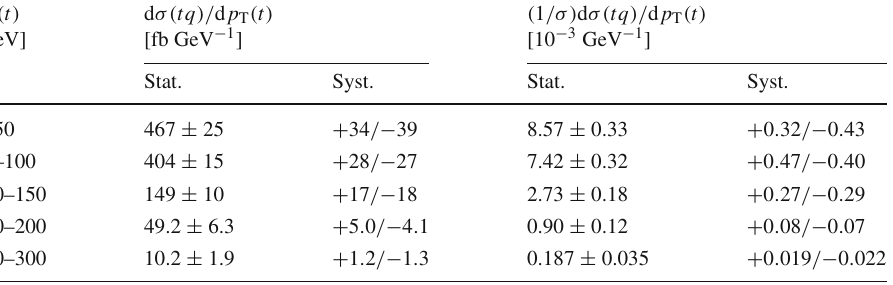
normalised unfolded differential ¯ tq production cross-section as a function of p T ( t ) at parton level